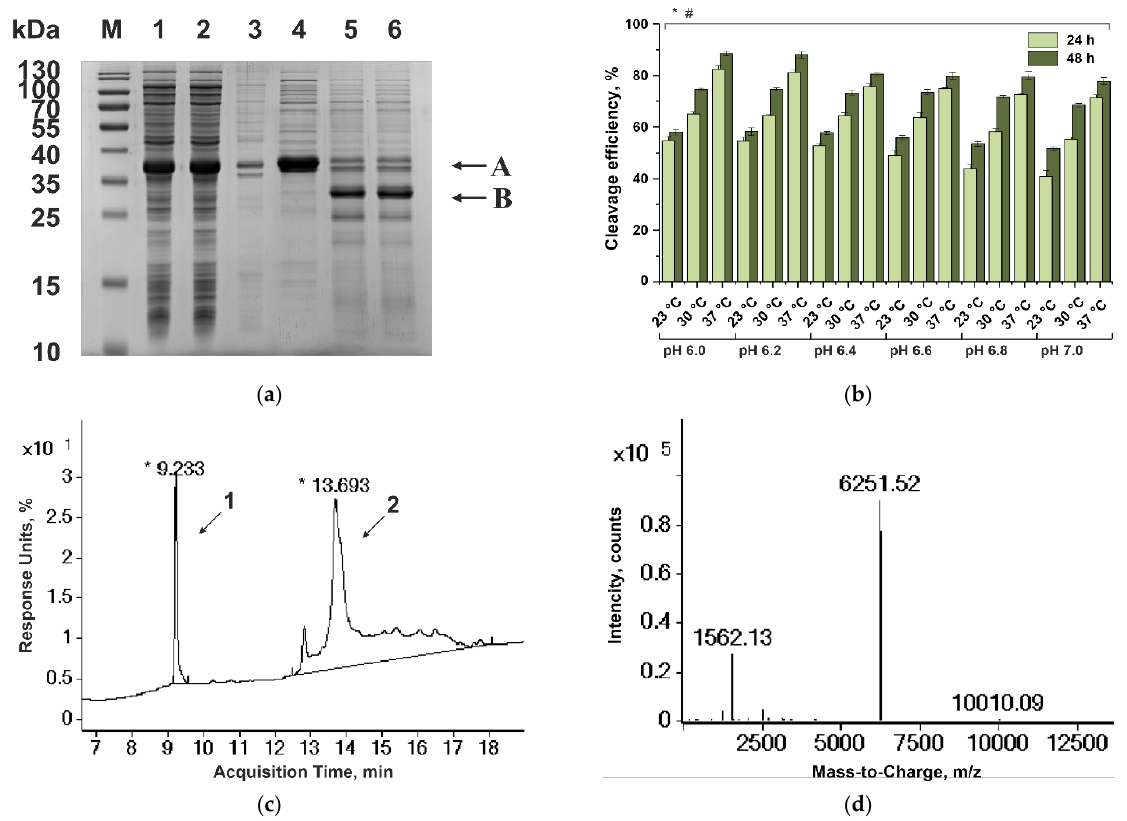
Figure 1. Purification of haemadin. ( a ) SDS-PAGE analysis of the purification and cleavage of the GyrA-Hae fusion protein. M, molecular mass markers; lane 1, crude cell lysate; lane 2, cell supernatant; lane 3, cell debris; lane 4, purified GyrA-Hae fusion protein after anion IEX; lanes 5–6, products of fusion protein cleavage at pH 6.0 and 37 °C for 24 h (lane 5) and 48h (lane 6). Arrows indicate theGyrA-Hae fusion protein (A) and residual protein CBD-GyrA (B). ( b ) Diagram of GyrA-Hae fusion protein cleavage in the range pH 6.0 to 7.0 at 23, 30, and 37 °C for 24 and 48 h. * indicates p ≤ 0.05 for the comparison of incubation time between 24 and 48 h, according to a Mann–Whitney test; # indicates p ≤ 0.05 for the comparison of incubation temperature between 23 and 37 °C, according to Kruskal–Wallis test. ( c ) RP-HPLC analysis of GyrA-Haefusion protein cleavage for 48 h at pH 6.0 and 37 °C. Arrows indicate haemadin ( 1 ) and residual protein CBD-GyrA ( 2 ). RP-HPLC in YMC-Pack C8 (Octyl) column (30 nm, 3 μm, 150 × 2.1 mm), elution with an acetonitrile gradient (8–64%) in 0.1% TFA at a rate of 0.3 mL/min. ( d ) ESI-TOF mass spectrum of haemadin. The fermentation of E. coli strain BL21 (DE3)/pERIG-Hae was scaled up from 300 mL shake flasks to a 75 L industrial fermenter. As a result of 50 L batch fermentation, 780 g of wet cell biomass (15.6 ± 0.8 g/L) was obtained. The relative content of the GyrA-Hae fusion protein was 27.80 ± 1.23 % of the total cell protein. The developed protocol allowed to isolate haemadin from 100 g of cell biomass per production cycle. After purification by anion-exchange chromatography, the fusion protein was cleaved at selected conditions (48 h at pH 6.0 and 37 °C) with stirring at 300 rpm. Such a technological approach accelerated the dynamic of fusion protein cleavage: 82.30% efficiency was achieved after 24 h incubation and reached up to 86.90% after 48 h. At the next step, the procedure involved anion IEX with a pH gradient, RP-HPLC, and SEC was used to purify haemadin from the uncleaved fusion protein, CBD-tagged mini-intein, and cell proteins. This semi-preparative scheme allowed us to isolate 497 mg of haemadin with pharmaceutical purity (above 98.0%) from 100 g of cell biomass (77.5 mg protein per liter of cell culture; Table S2). The actual yield reached 68.57% of that theoretically